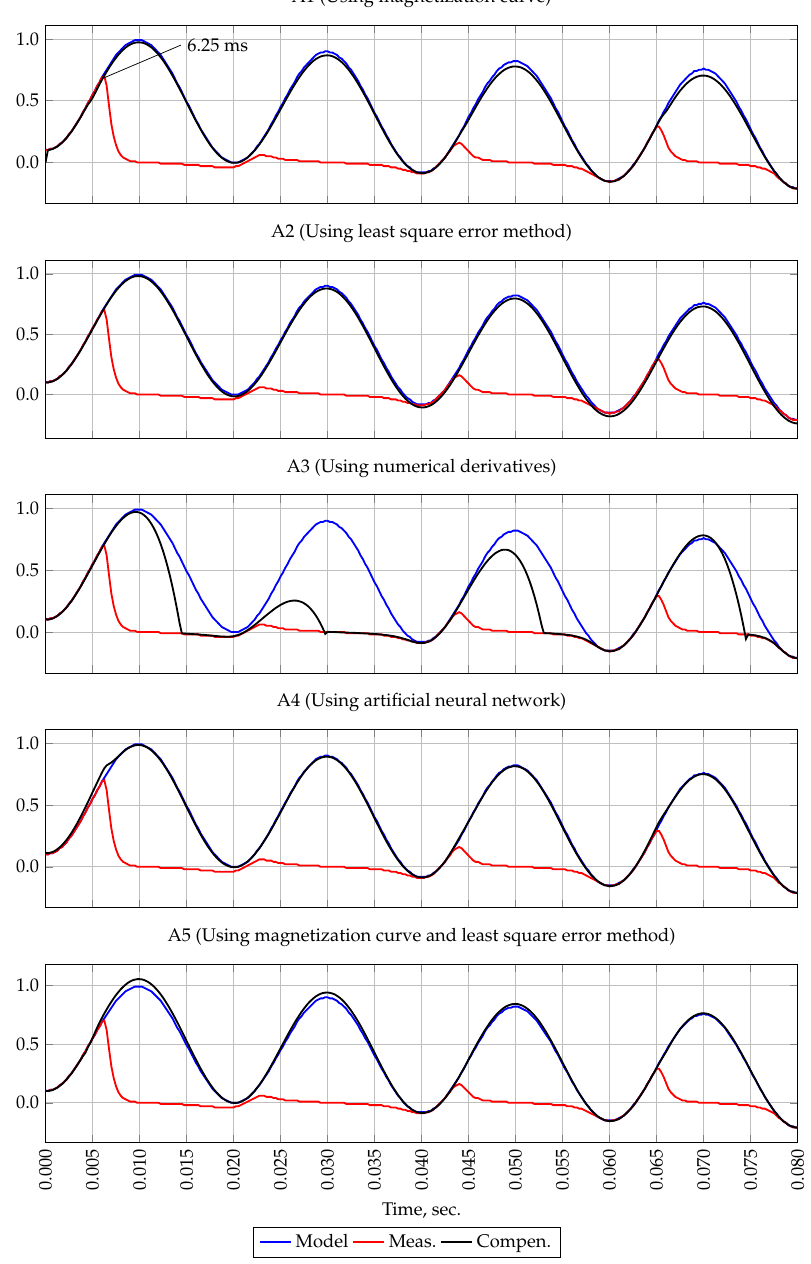
Figure 4. Oscillogram of currents, experiment 1